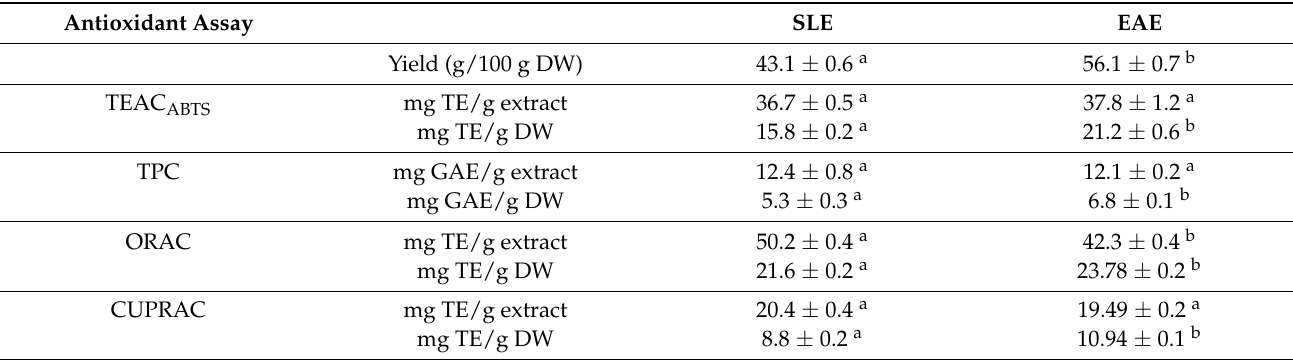
Table 2. Comparison of the yield and in vitro antioxidant capacity of the water-soluble fractions of bilberry pomace obtained using SLE and